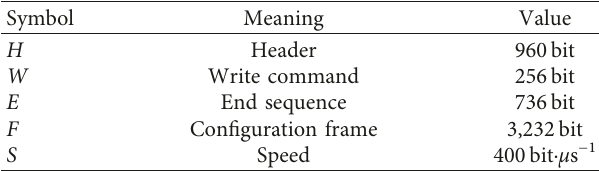
Table 1: Values of the